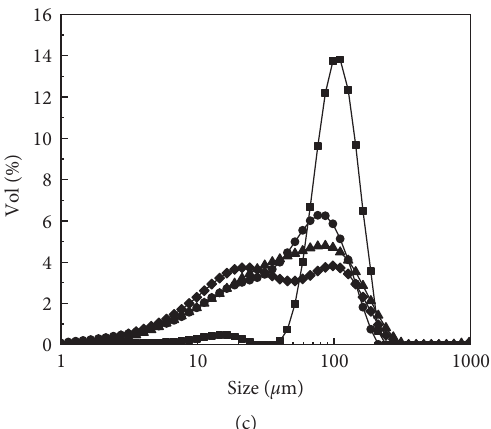
2 powder: (a) 38–63 μ m TiH 2 , (b) 63–88 μ m TiH 2 , and